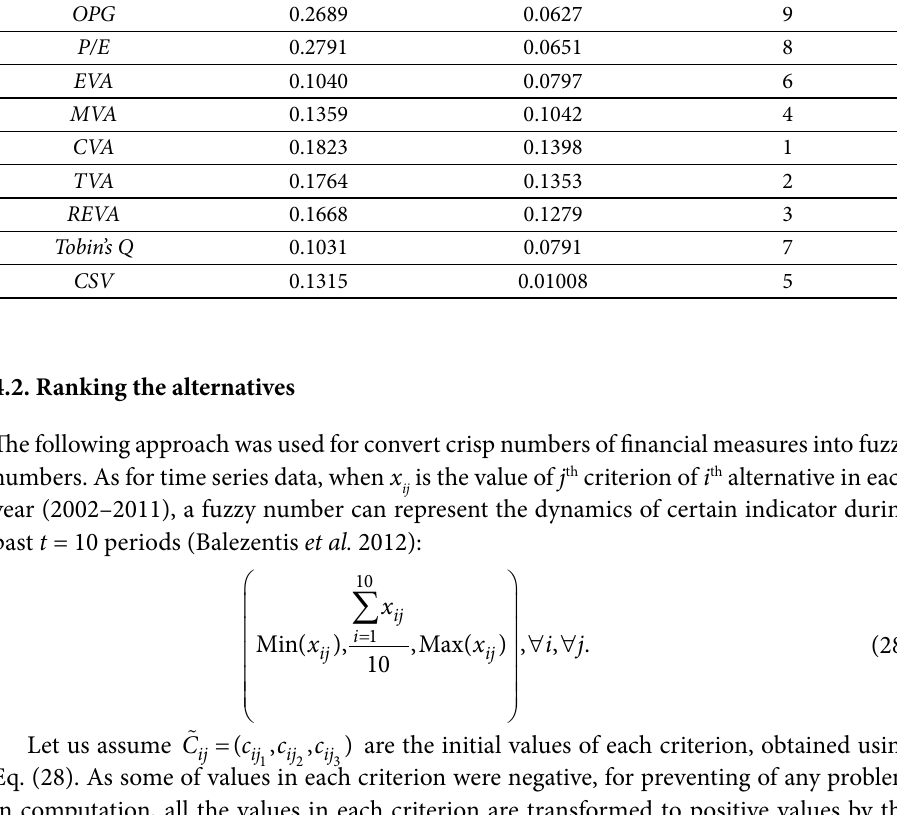
Table 5. Weights of sub criteria obtained from FAHP Sub criteria Local Weights Total Weights Rank ROA OPG